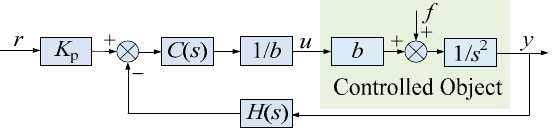
Figure 6. Simplified structure of LADRC.